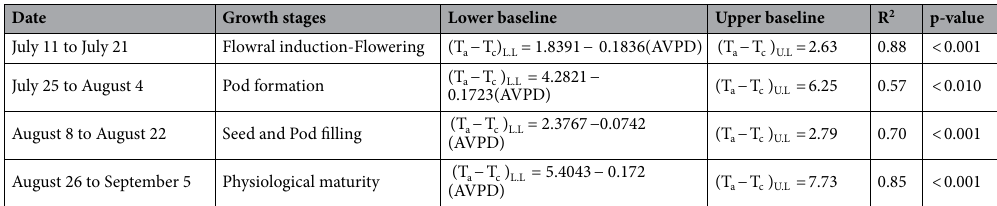
Table 6. Equations for lower and upper baselines by Idso et al.32 for four stages of black gram growth. dT L.L : lower baseline; dT